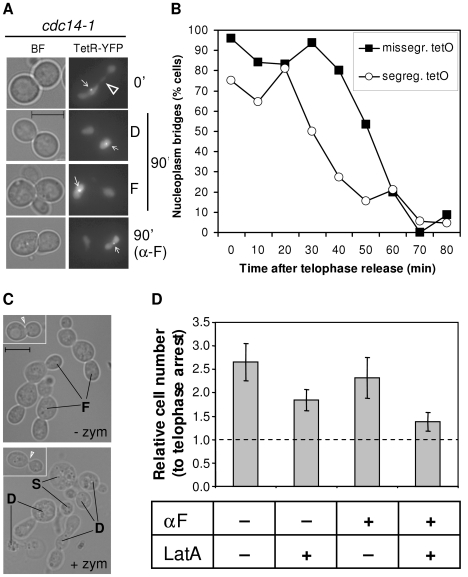
Cells complete karyo- and cytokinesis after a cdc14-1 release, irrespective of the cXIIr segregation status.(A) Strain FM518 (cdc14-1 tetO:487 TetR-YFP) was first arrested at 37°C for 3 hours and micrographed in the conditions described to see the tetR-YFP nucleoplasm bridge (0′, see also Figure S5). Then it was released at 25°C. Part of the yeast culture was released into fresh medium containing alpha-factor to arrest the daughter cells in G1. At 90 minutes after the release, more photos were taken and representative cells are shown. The two main cell morphologies at that time for a normal release, dumbbells [D] and foursomes [F], are depicted. The hollow triangle points to the nucleoplasm bridge. White pointers indicate the missegregated tetO. Note that cells have no nucleoplasm bridge. (B) Time course of nucleoplasm bridge disappearance for the same strain relative to the cXIIr segregation status. (C) Strain FM515 (cdc14-1 RAD52-YFP) was arrested in telophase by incubation at 37°C for 3 hours. Then the cell culture was shifted back to 25°C to enter a new cell cycle. At the time of the telophase block and 2 hours after the release, samples were taken and fixed with formaldehyde. Contrasted bright field micrographs of representative cells before and after zymolyase treatment are shown. Left corner photos show cells at the telophase block. The white triangle highlights the difference in bud neck thickness after zymolyase treatment. Main photos depict cells 2 hours after the telophase release. “F” points to foursomes, “D” to dumbbells and “S” to single cells. No foursomes (<3%) were seen after zymolyase treatment. (D) Strain FM515 (cdc14-1 RAD52-YFP) was treated to inhibit cytokinesis (+LatA) and/or cell cycle progression beyond G1 (+αF). The number of cells was counted in a haemocytometer after the zymolyase treatment. The chart represents cell number two hours after the release relative to their telophase block (mean ± SEM, n = 3).